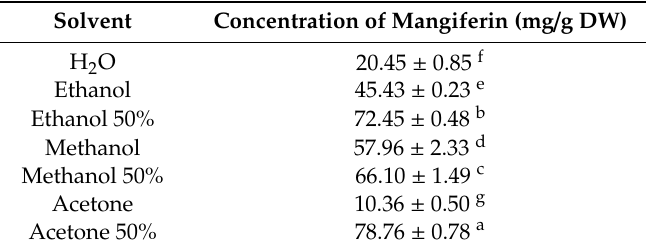
Table 2. Impact of type of solvent on recovery of mangiferin from S. chinensis